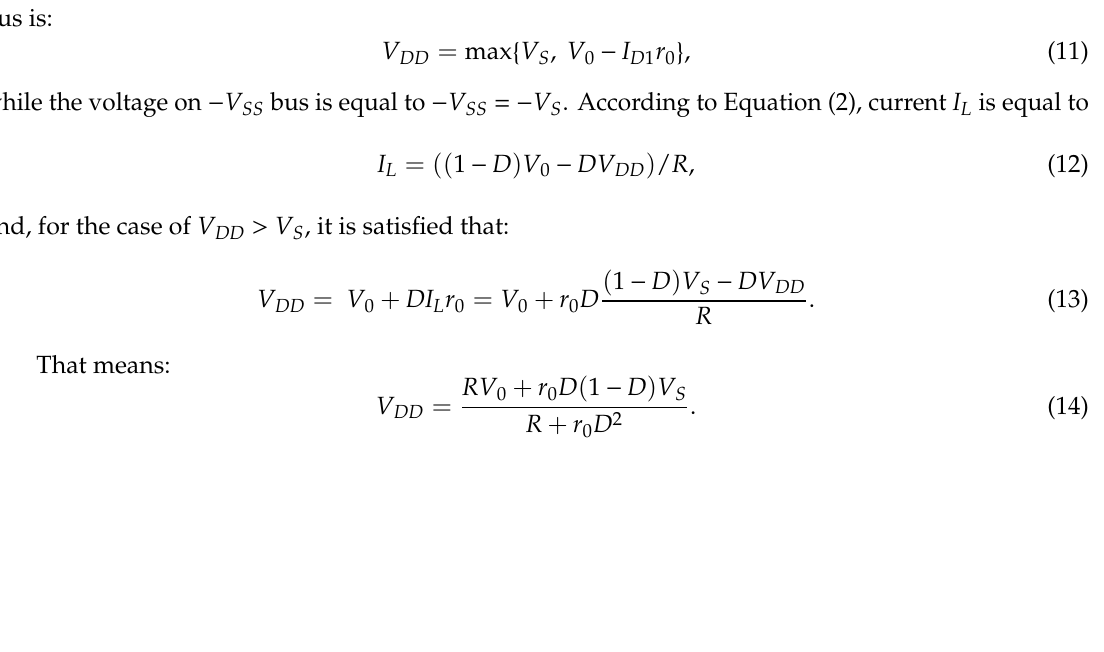
Figure 5. Equivalent representation of subcircuits U 1 and U 2 . Typically, voltage source V DZ is made of Zener diode with breakdown voltage V DZ . Subcircuits U 1 and U 2 consume energy and, therefore, are thermodynamically passive.